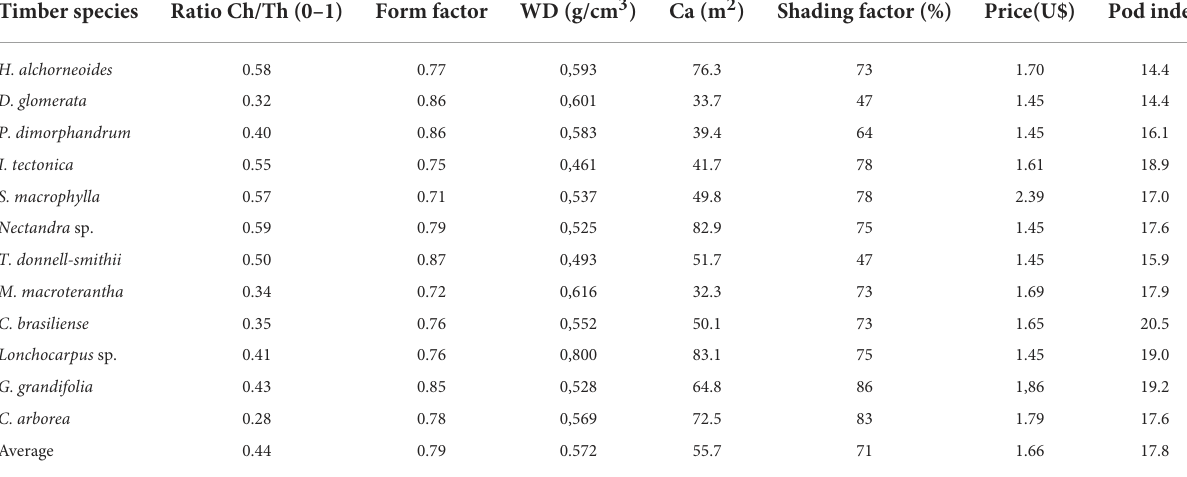
TABLE 3 Tree attributes, basic wood density, crown area, shading factor, and cacao pod index under 12 timber shade trees in the experimental site “CEDEC-JAS” La Masica, Atlántida, Honduras. Timber species